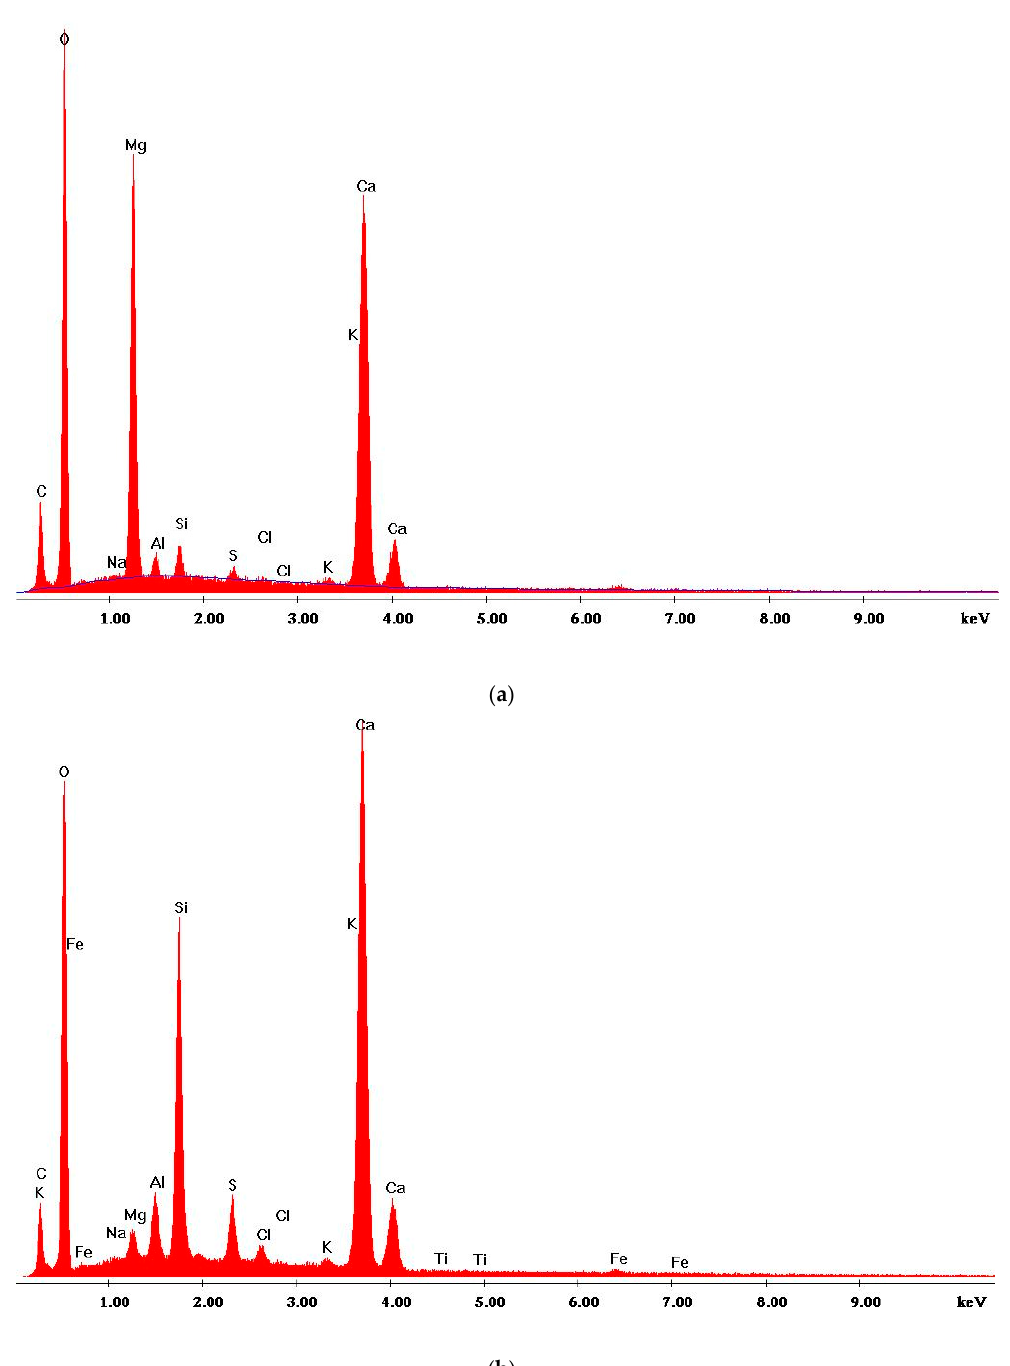
Figure 11. Example di ff ractogram of the analyzed area of modified concrete composite: ( a ) 20 ◦ C, 5% of glass; ( b ) 800 ◦ C, 5% of